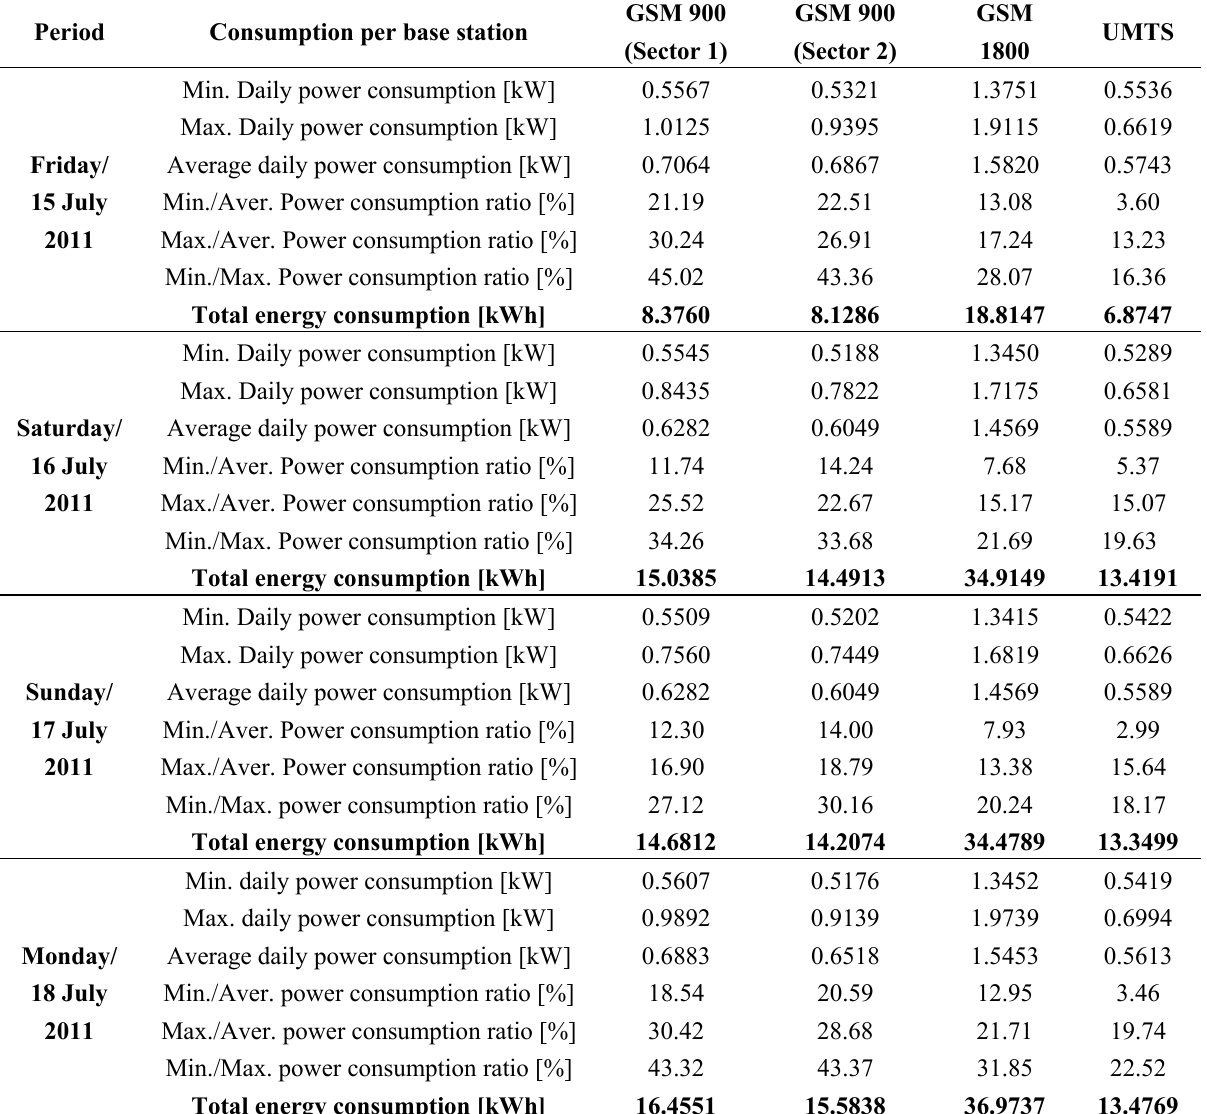
Table 2. DC power consumption